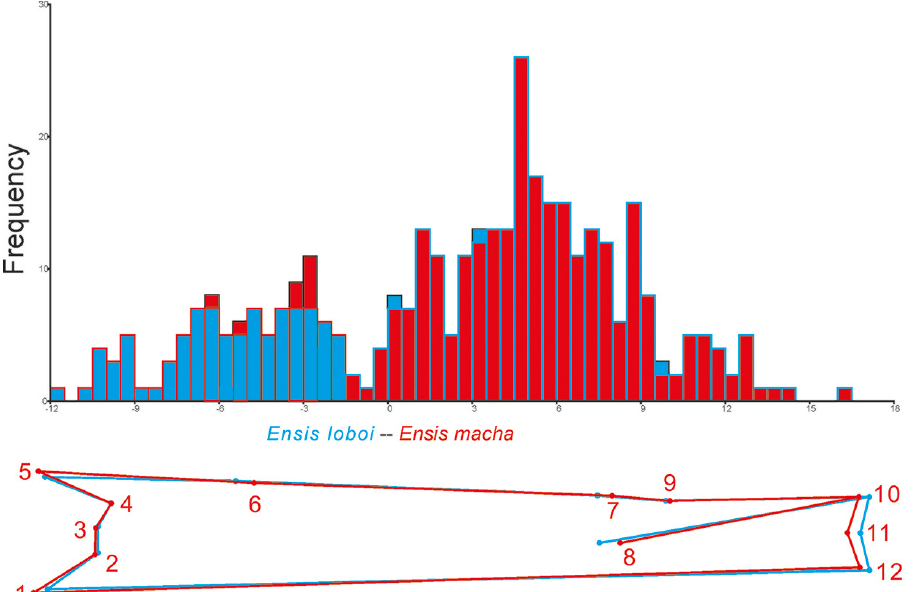
Fig. 3. – Discriminant analysis on inner shell shape of the Ensis southernmost species. The classification of discriminant frequencies predicted by the iterative cross-classification analysis between E. loboi n. sp . (cyan bars and wireframe graph) and E. macha (red bars and wireframe graph) are